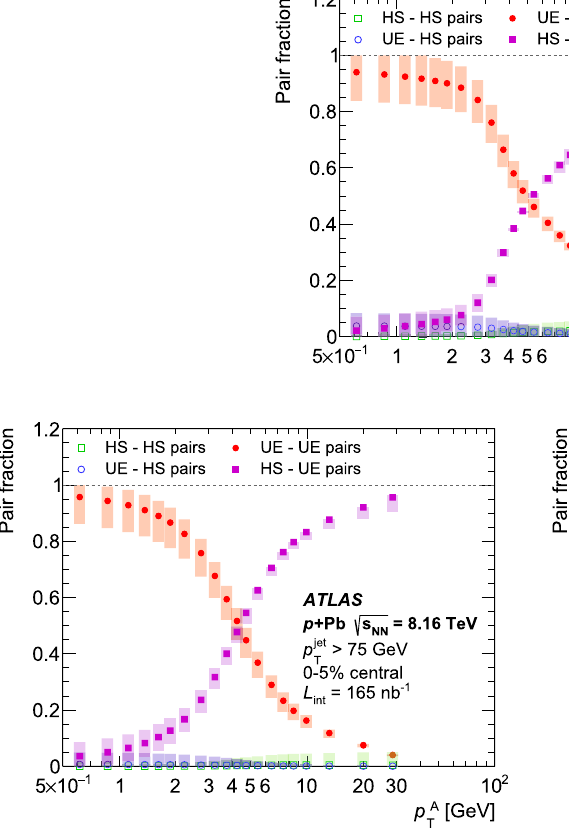
tively, and red and violet closed circles represent UE–UE and HS–UE pairs, respectively. Statistical uncertainties are shown as narrow verti- cal lines on each point, and systematic uncertainties are presented as coloured boxes behind the